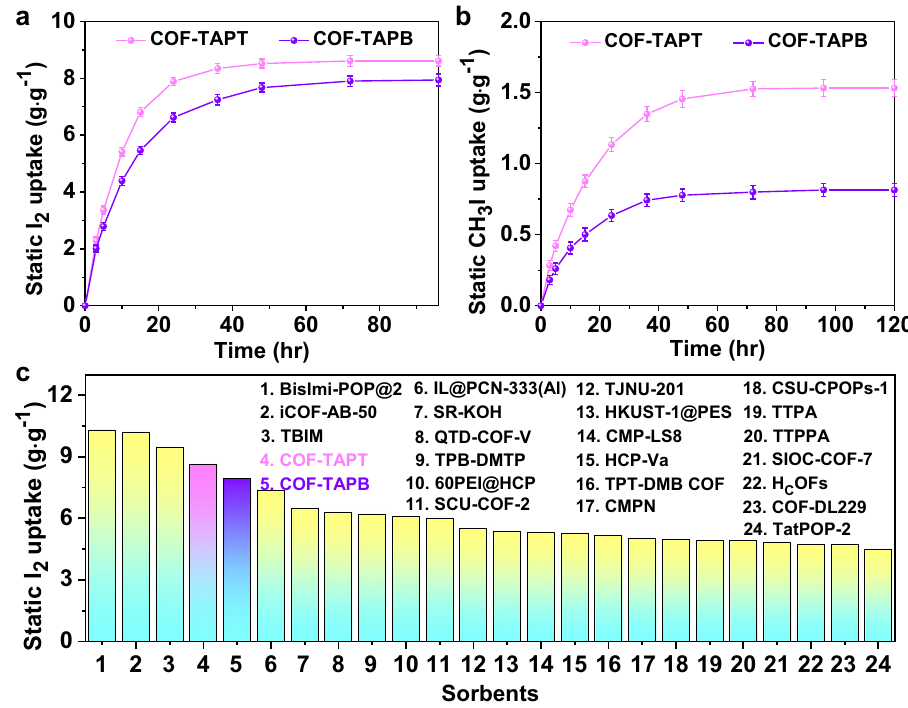
Fig. 3 Static I 2 and CH 3 I adsorption performance. Gravimetric measurement of static a I 2 and b CH 3 I vapor adsorption capacities of COF-TAPT and COF- TAPB materials as a function of time at 75 °C. c Comparison of the static I 2 adsorption capacities of various high-performance adsorbents. The speci fi c I 2 uptake values of the reported adsorbents and corresponding references are presented in Supplementary Table 5. The error bars are the standard deviations from three parallel